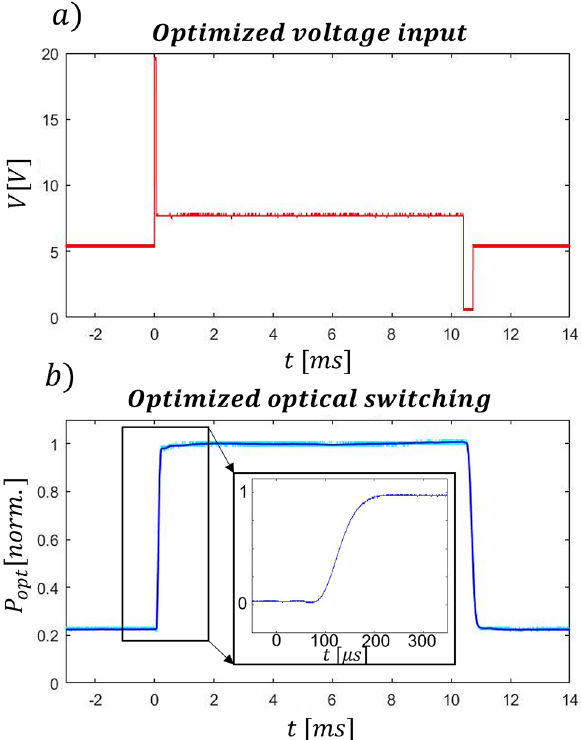
Figure 6. ( a ) Optimized voltage function to achieve the fastest output switching. ( b ) Corresponding output power, with a τ ON and τ OFF equal to 78 μs and 209 μs, respectively (asymmetric